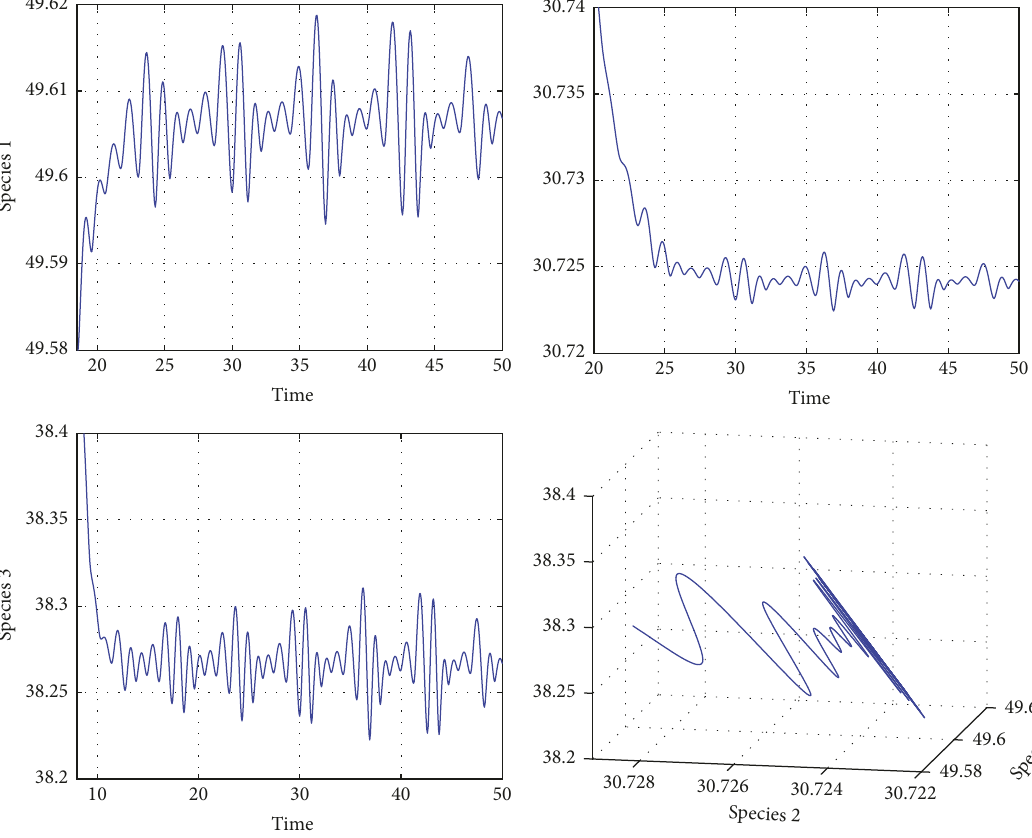
Figure 7: Dynamical behaviors and phase space trajectories of the three marine